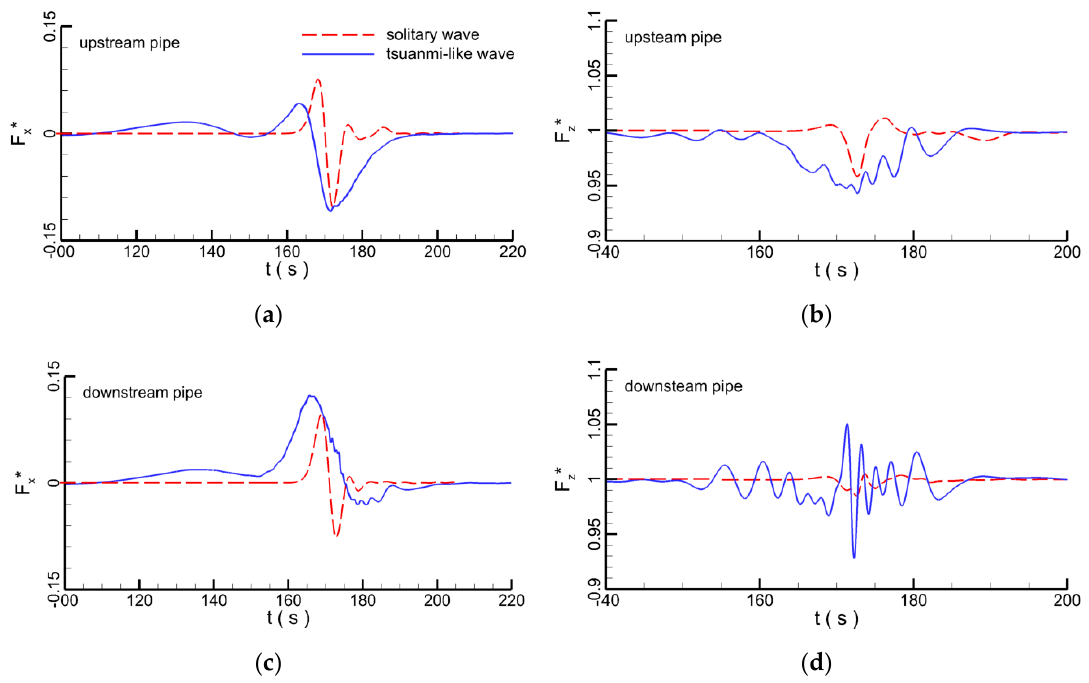
Figure 30. Temporal evolution of the hydrodynamic forces at pipelines with spacing distance 1 D under the impact of solitary and tsunami-like waves; ( a ) horizontal force of upstream pipe F x *; ( b ) vertical force of downstream pipe F z *; ( c ) horizontal force of downstream pipe F x *; ( d ) vertical force of downstream pipe F z *.